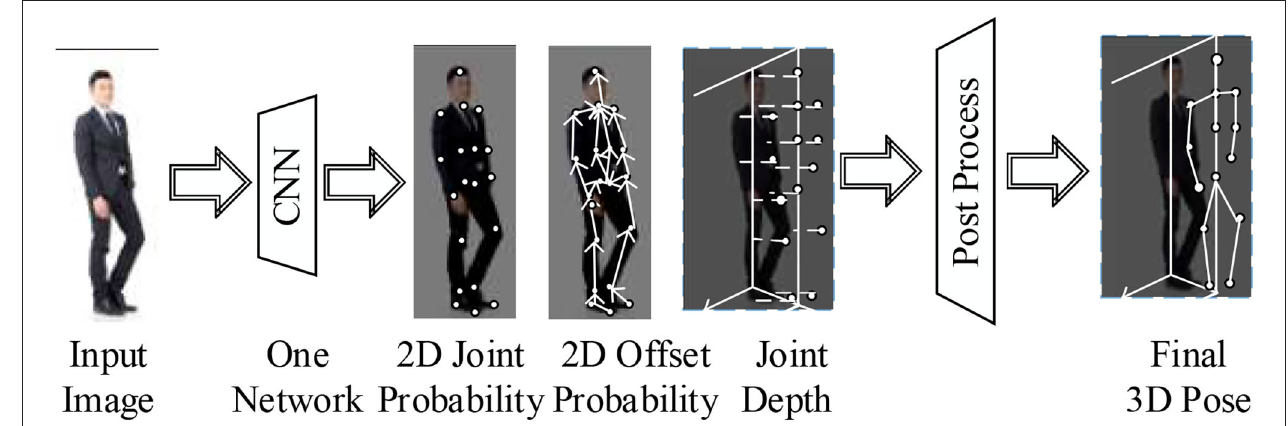
FIGURE 3 | The network structure framework of the 3D estimation algorithm for human body